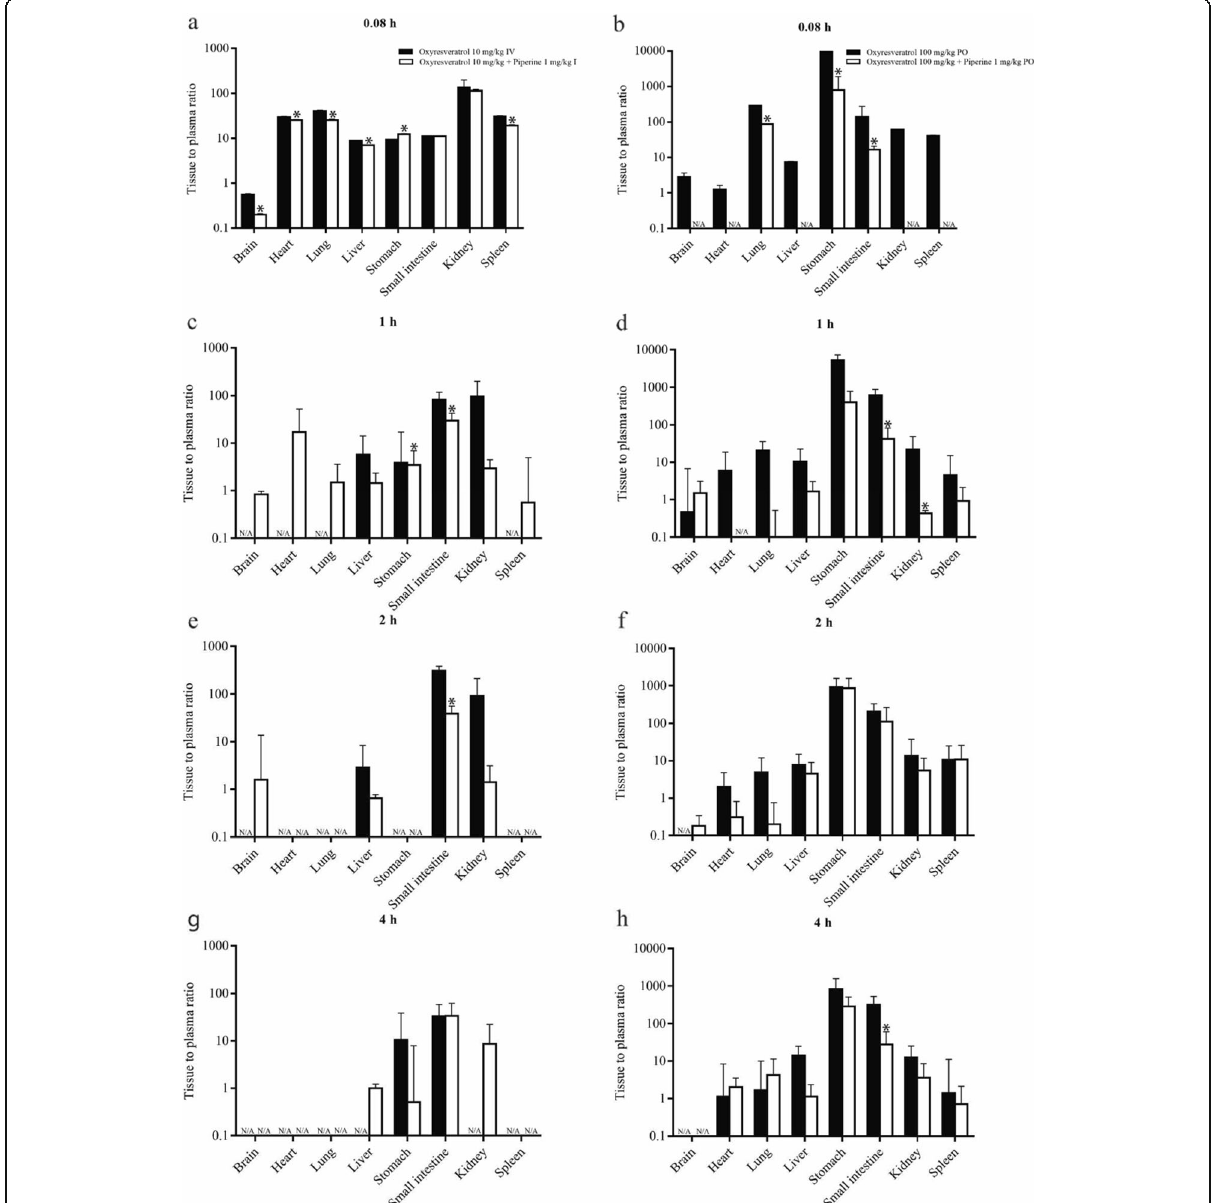
Fig. 3 Tissue to plasma ratios of oxyresveratrol alone (black bars) and in combination with piperine (white bars) after intravenous dosing ( a , c , e , g ) after oral dosing ( b , d , f , h